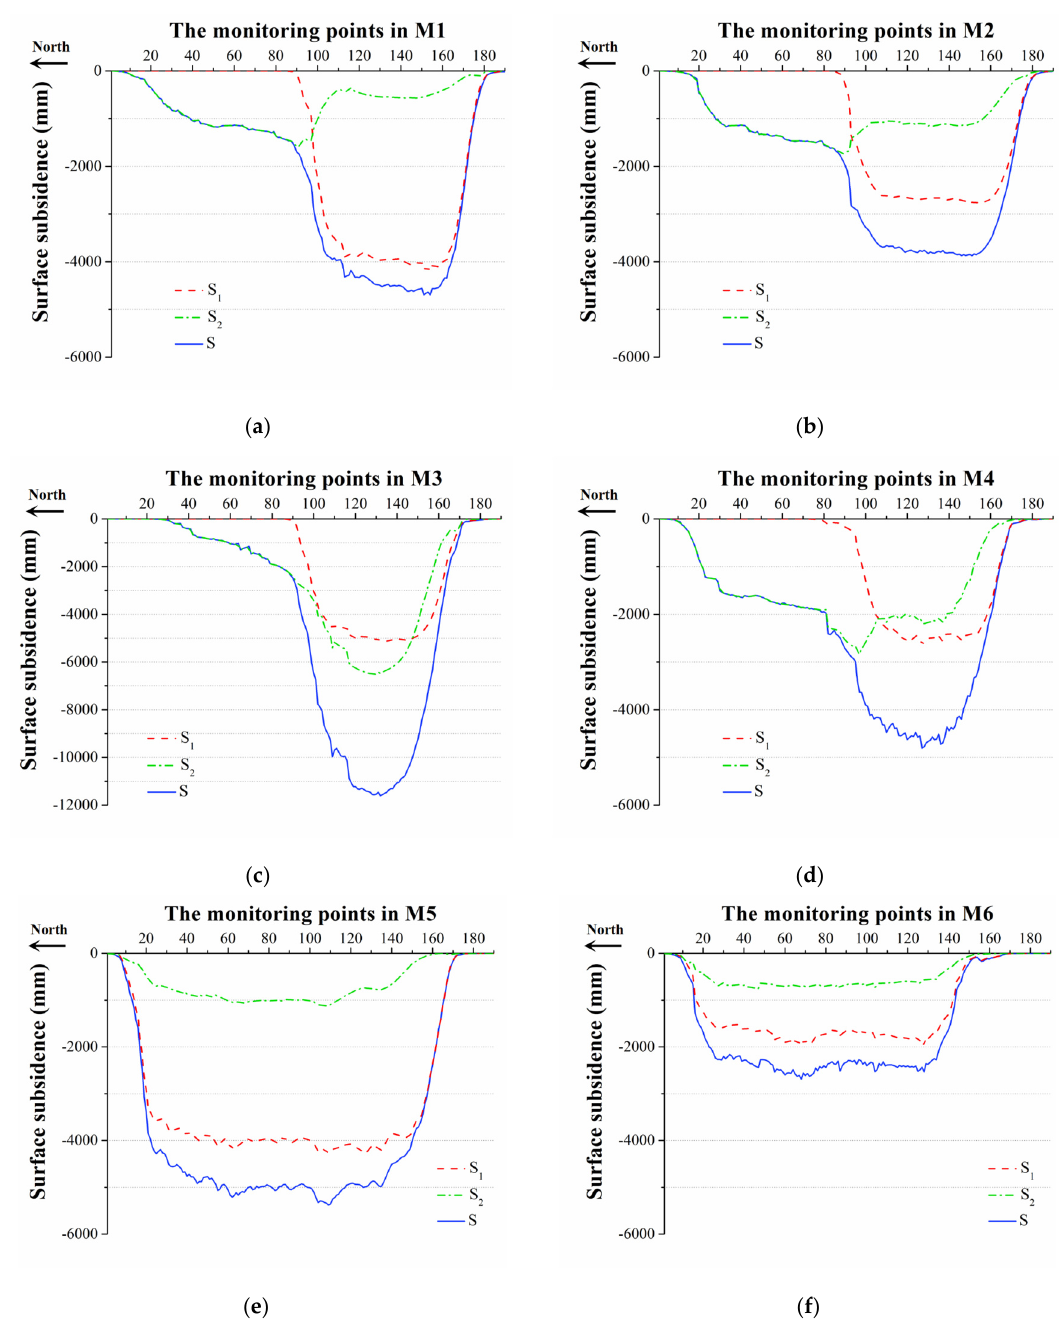
Figure 13. Results of surface subsidence by FLAC 3D numerical simulation (M1–M6 are the monitoring lines shown in Figure 3). The dashed lines are S 1 . The dotted lines are S 2 . The solid lines are S.